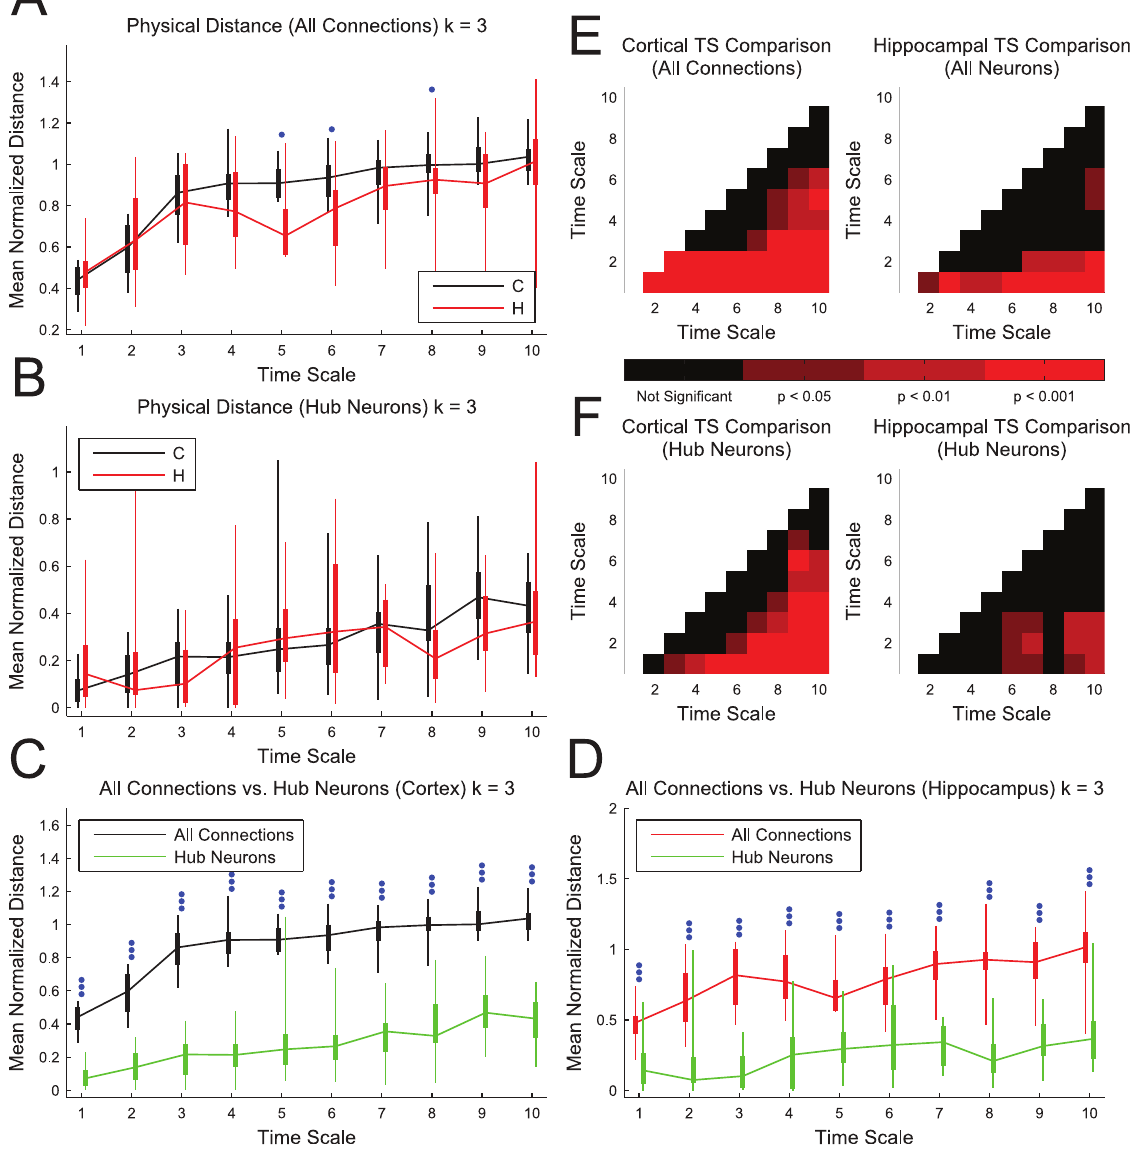
Fig. 6. Physical distance between connected neurons increased with time scale and hubs were closely spaced. ( A ) The mean physical connection distance was calculated as the ratio of the mean physical distance between effectively connected neurons in the network to the mean physical distance between all possible pairs of neurons in the sub-network. Cortical networks were found to be significantly larger for several time scales. ( B ) The mean physical distance between hubs was calculated as the ratio of the mean physical distance between hubs (connected or not connected) to the mean physical distance between all possible pairs of neurons in the sub-network. No significant differences between hippocampal and cortical networks were observed. ( C and D ) The hubs were significantly more closely spaced than the average connected pair. Box plots: minimum, 25 th percentile, median, 75 th percentile, maximum data set (recording). Differences between hippocampal and cortical networks were assessed with a multiple comparisons corrected Mann- Whitney Test (one dot: p , 0.05, two dots: p , 0.01, three dots: p , 0.001). ( E and F ) Multiple comparisons corrected Mann-Whitney Test p-values between different time scales for the same tissue type for connection distances (E) and hub distances (F). Note that cortical and hippocampal network connections tend to be significantly longer in time scales 3 to 10 in comparison to time scales 1 and 2. Also, note that hub distances generally increase with time